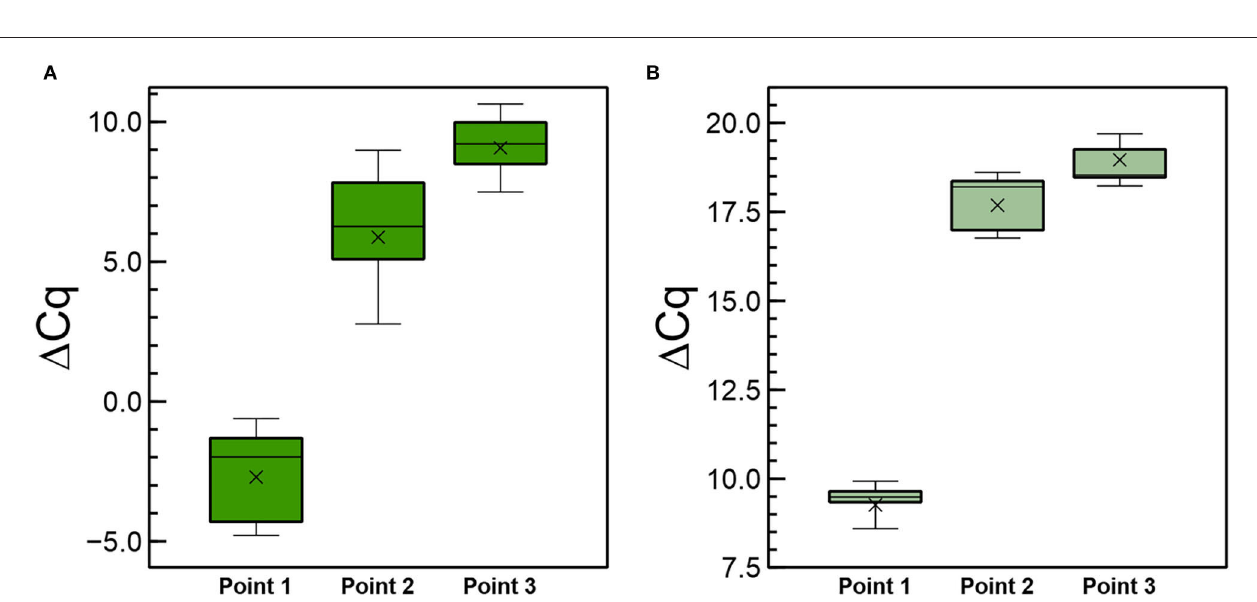
FIGURE 6 | Quantitative differences at 3 dpt in (A) CP-ds(RNA) and (B) 5,234- or 6,125-vsiRNA amounts in distal (point 2) non-treated leaves among plants either directly sprayed with CP-dsRNA (dsRNA-CP) or agroinfiltrated with the CP-dsRNA (Ag-CP) or the MP-dsRNA (Ag-MP) expressing constructions pGHE-CP and pGHE-MP mediated by A. tumefaciens LBA4404.